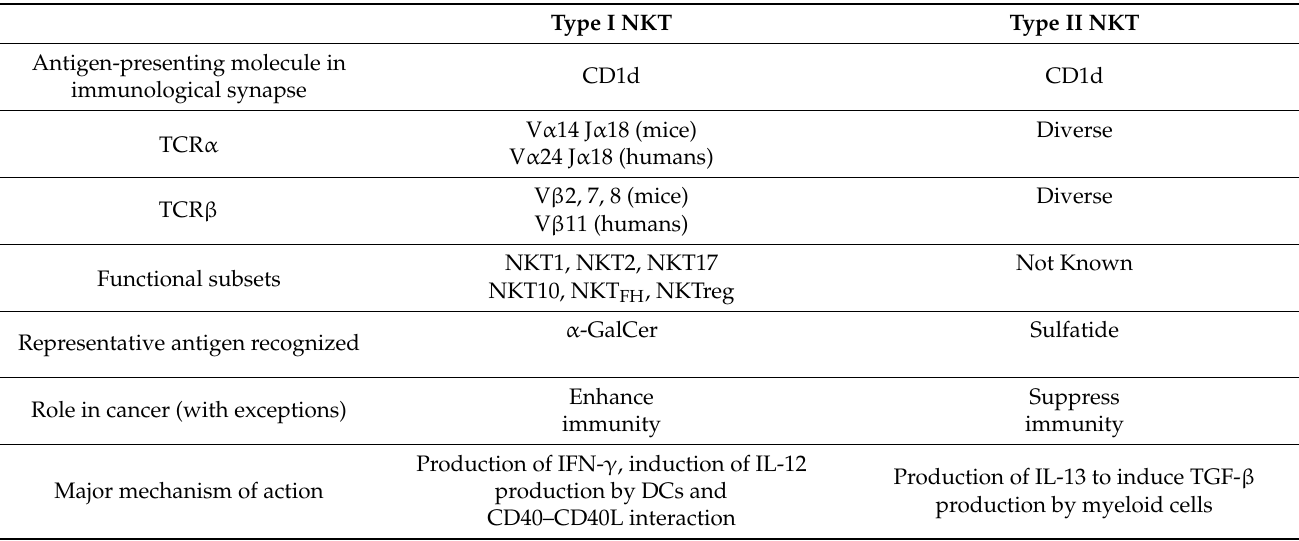
Table 1. Characteristics of type I and type II NKT